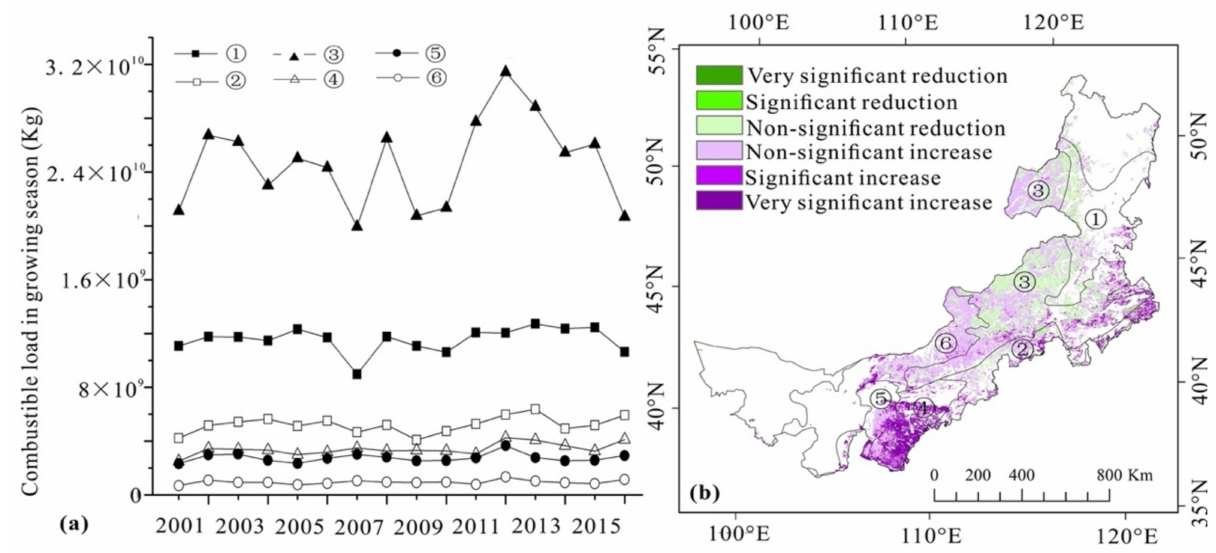
Figure 5. Combustible load statistics of different vegetation subclasses from 2001 to 2016 growing seasons ( a ) and MK test ( b ) (Note: 1 (cid:13) – 6 (cid:13) see Figure